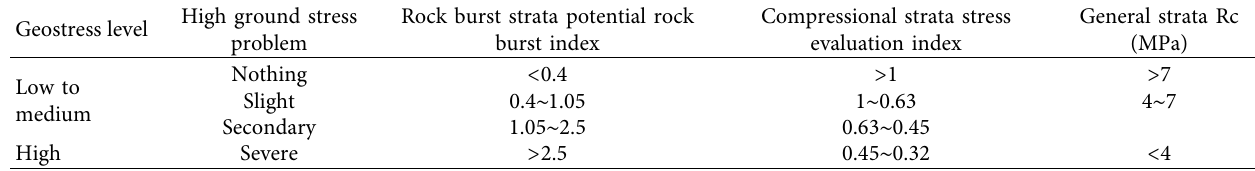
Table 3: Disaster risk assessment of underground roadway construction under different in situ stress levels.